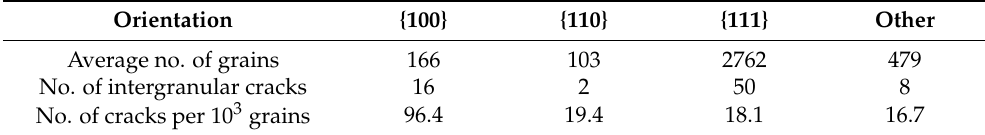
The relationship between the number of hydrogen-induced microcracks and the grain